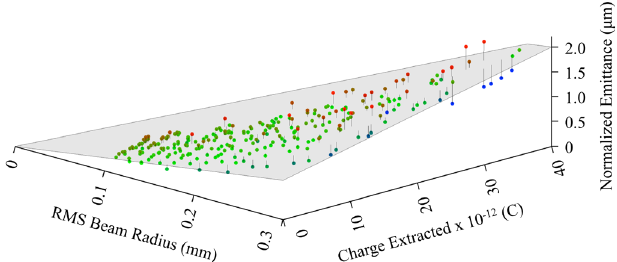
FIG. 5. Dependence of transverse emittance from CsBr on extracted charge and laser spot size taken at 80 MV = m field, − 15 ° rf-laser phase. An emperical plane of best fit is shown in grey. Data above the fit are colored increasingly red. Data below the fit are colored increasingly blue. Data that match the fit are colored green.